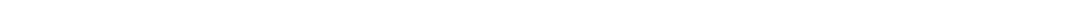
(see fi gure on previous page) Fig. 4 miR-541-3p enhances the radiosensitivity of PCa cells through downregulating β -catenin by inhibiting HSP27. In C – F , miR-NC, miR- 541-3p, oe-NC, and oe-HSP27 were transfected into LNCaP cells. G – J The effect of HSP27 and β -catenin on the radiosensitivity mediated by miR-541- 3p in LNCaP cells. A The protein expression of β -catenin in PCa tissues and adjacent normal tissues measured by western blot assay. ** p < 0.01 relative to the adjacent normal tissues. B The protein expression of HSP27 and β -catenin in LNCaP cells with or without radiation measured by western blot assay. ** p < 0.05 relative to LNCaP cells after 0 Gy radiation. C The expression level of miR-541-3p determined by RT-qPCR. D The mRNA expression of HSP27 determined by RT-qPCR. E The expression level of β -catenin mRNA was detected by RT-qPCR. F The protein expression levels of HSP27 and β -catenin measured by western blot assay, ** p < 0.01 relative to the miR-NC and ## p < 0.01 relative to the oe-NC. & p < 0.01 relative to anti- NC; @ p < 0.01 relative to miR-541-3p + oe-NC. G HSP27 protein expression level measured by western blot assay, ** p < 0.01, compared with the miR- NC, ## p < 0.01. H The protein expression level of β -catenin measured by western blot assay, ** p < 0.01, compared with the miR-NC, ## p < 0.01. I